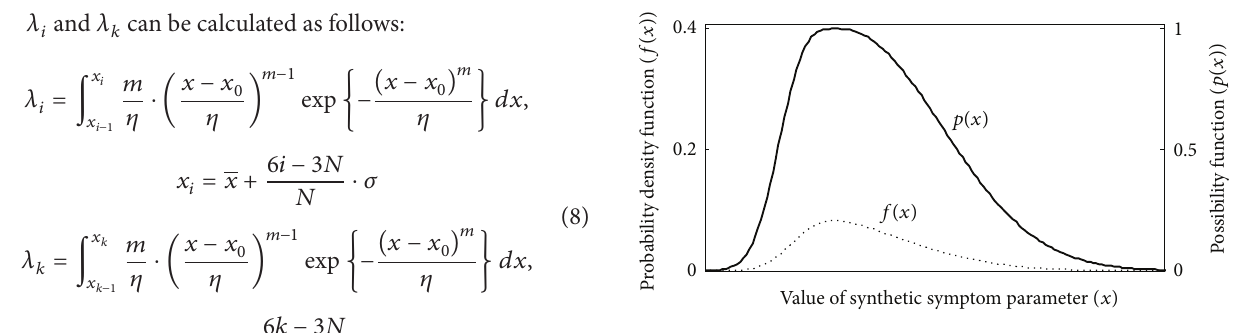
Figure 9: Probability density function ( 𝑓(𝑥) ) and possibility func- tion ( 𝑝(𝑥) ).